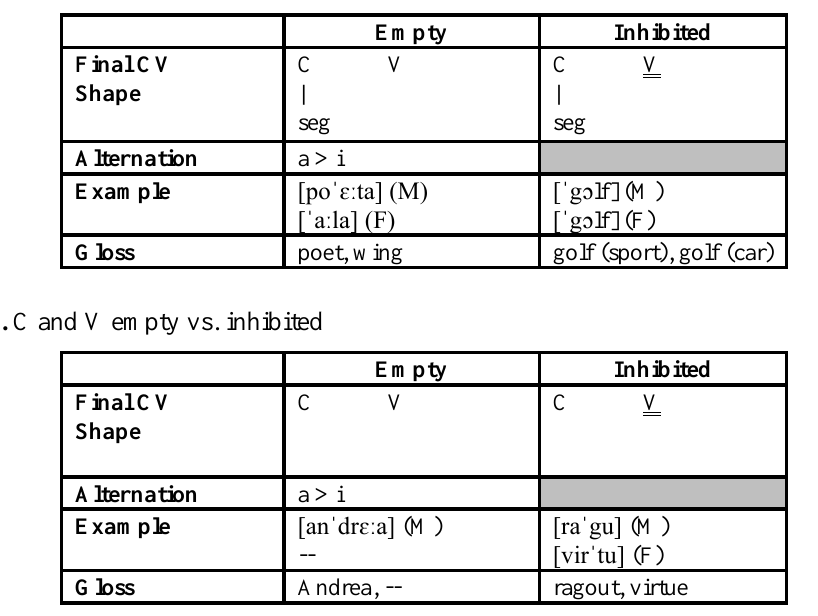
Table 3. C filled, V empty vs. inhibited